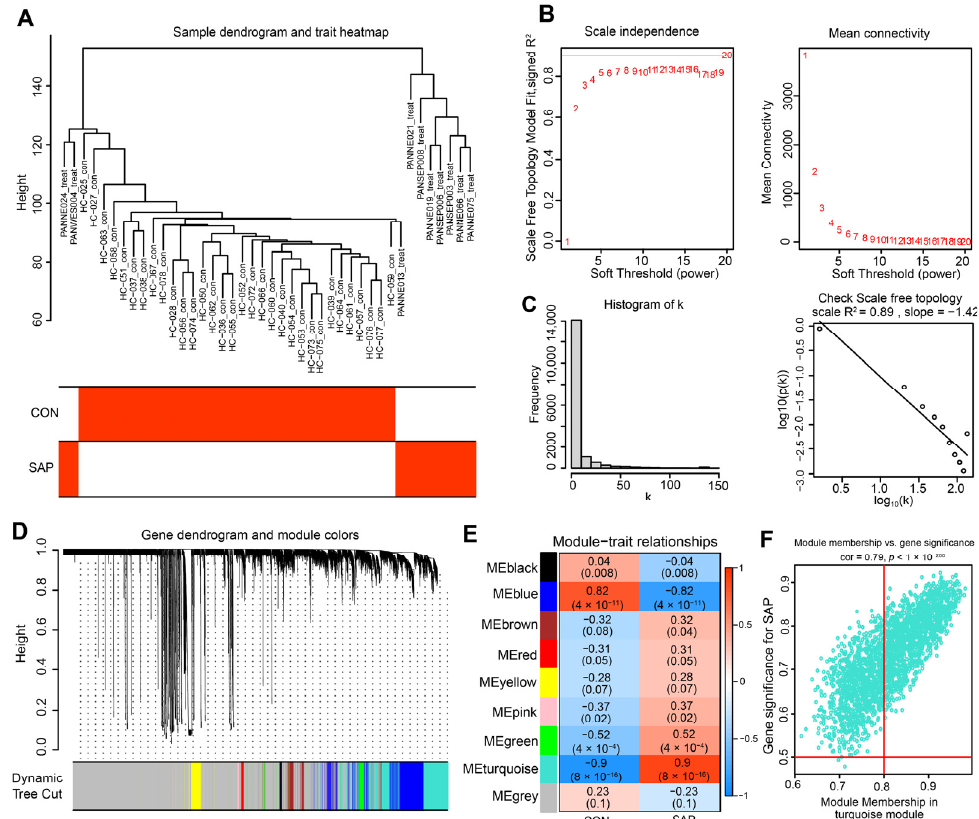
Figure 2. Construction of the co-expression network. ( A ) The sample dendrogram and feature heat map were drawn based on the Euclidean distance using the average clustering method for hierarchical clustering of samples, with each branch representing a sample, Height in the vertical coordinate being the clustering distance, and the horizontal coordinate being the clinical grouping information. ( B ) Soft threshold (power = 20) and scale-free topology fit index (R 2 = 0.89). ( C ) Histogram of connectivity distribution. The scale-free topology is checked at a soft threshold of 20. ( D ) Gene hierarchy tree-clustering diagram. The graph indicates different genes horizontally and the uncorrelatedness between genes vertically, the lower the branch, the less uncorrelated the genes within the branch, i.e., the stronger the correlation. ( E ) Heatmap showing the relations between the module and SAP features. The values in the small cells of the graph represent the two-calculated correlation values cor coefficients between the eigenvalues of each trait and each module as well as the corresponding statistically significant p -values. Color corresponds to the size of the correlation; the darker the red, the more positive the correlation; the darker the green, the more negative the correlation. ( F ) Scatter plot between gene salience (GS) and module members (MM) in turquoise.